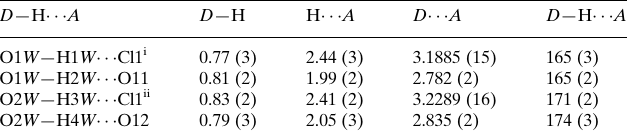
Hydrogen-bond geometry (A˚ , (cid:3)